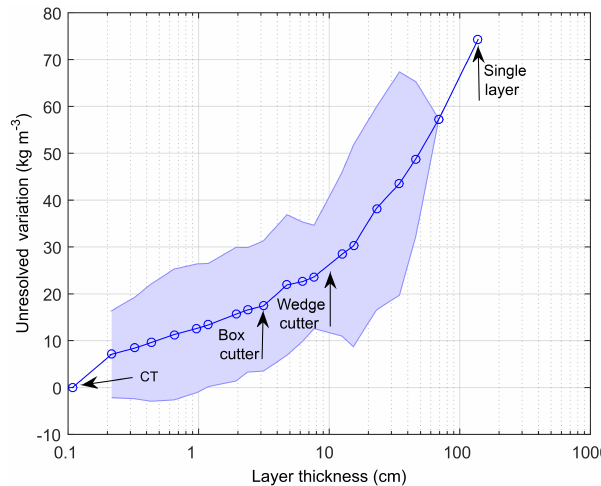
Figure 7. Unresolved variation of µ CT profile, vertically averaged to larger layer thickness, with the vertical resolution of box cutter (3cm), wedge cutter (10cm), and a single-layer profile indicated. The shaded area indicates ± 1 standard